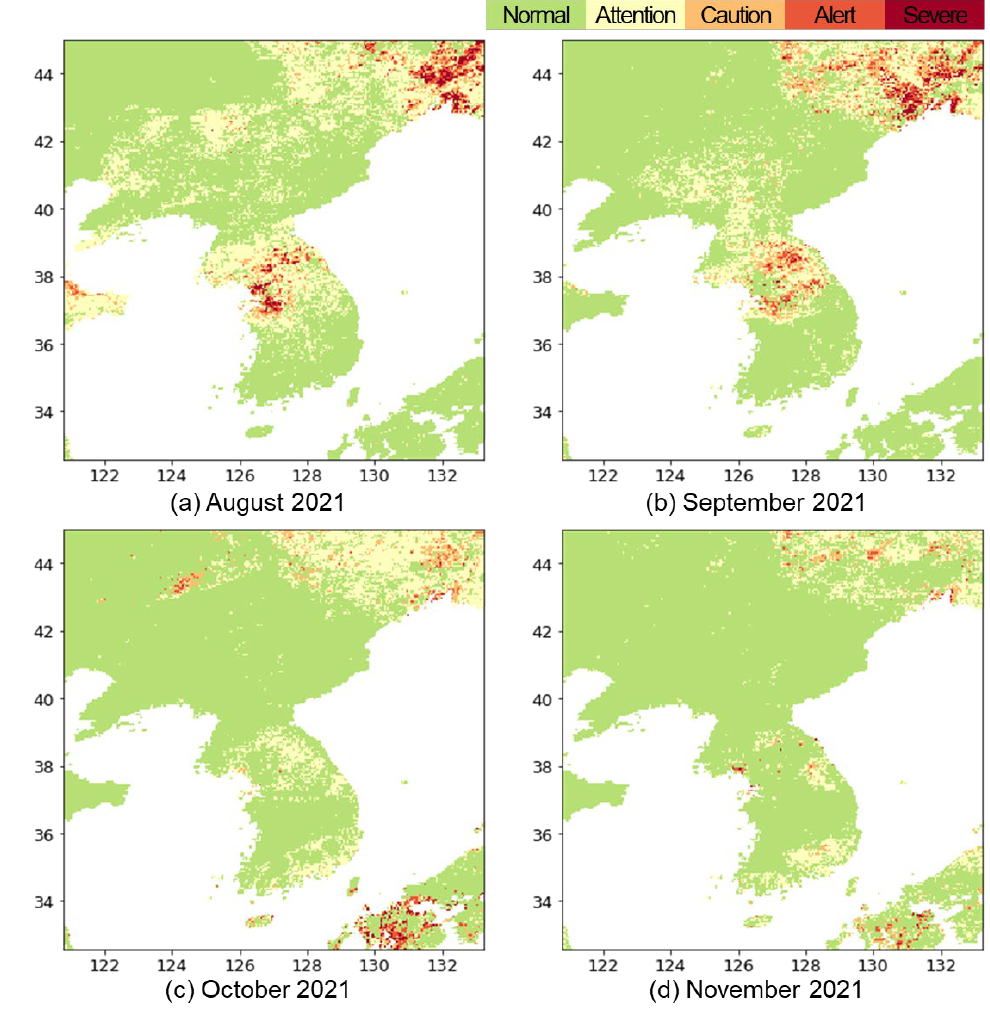
Figure 8. Ecological drought monitoring map by EDCI-veg for ( a ) August 2021, ( b ) September 2021, ( c ) October 2021 and ( d ) November 2021.